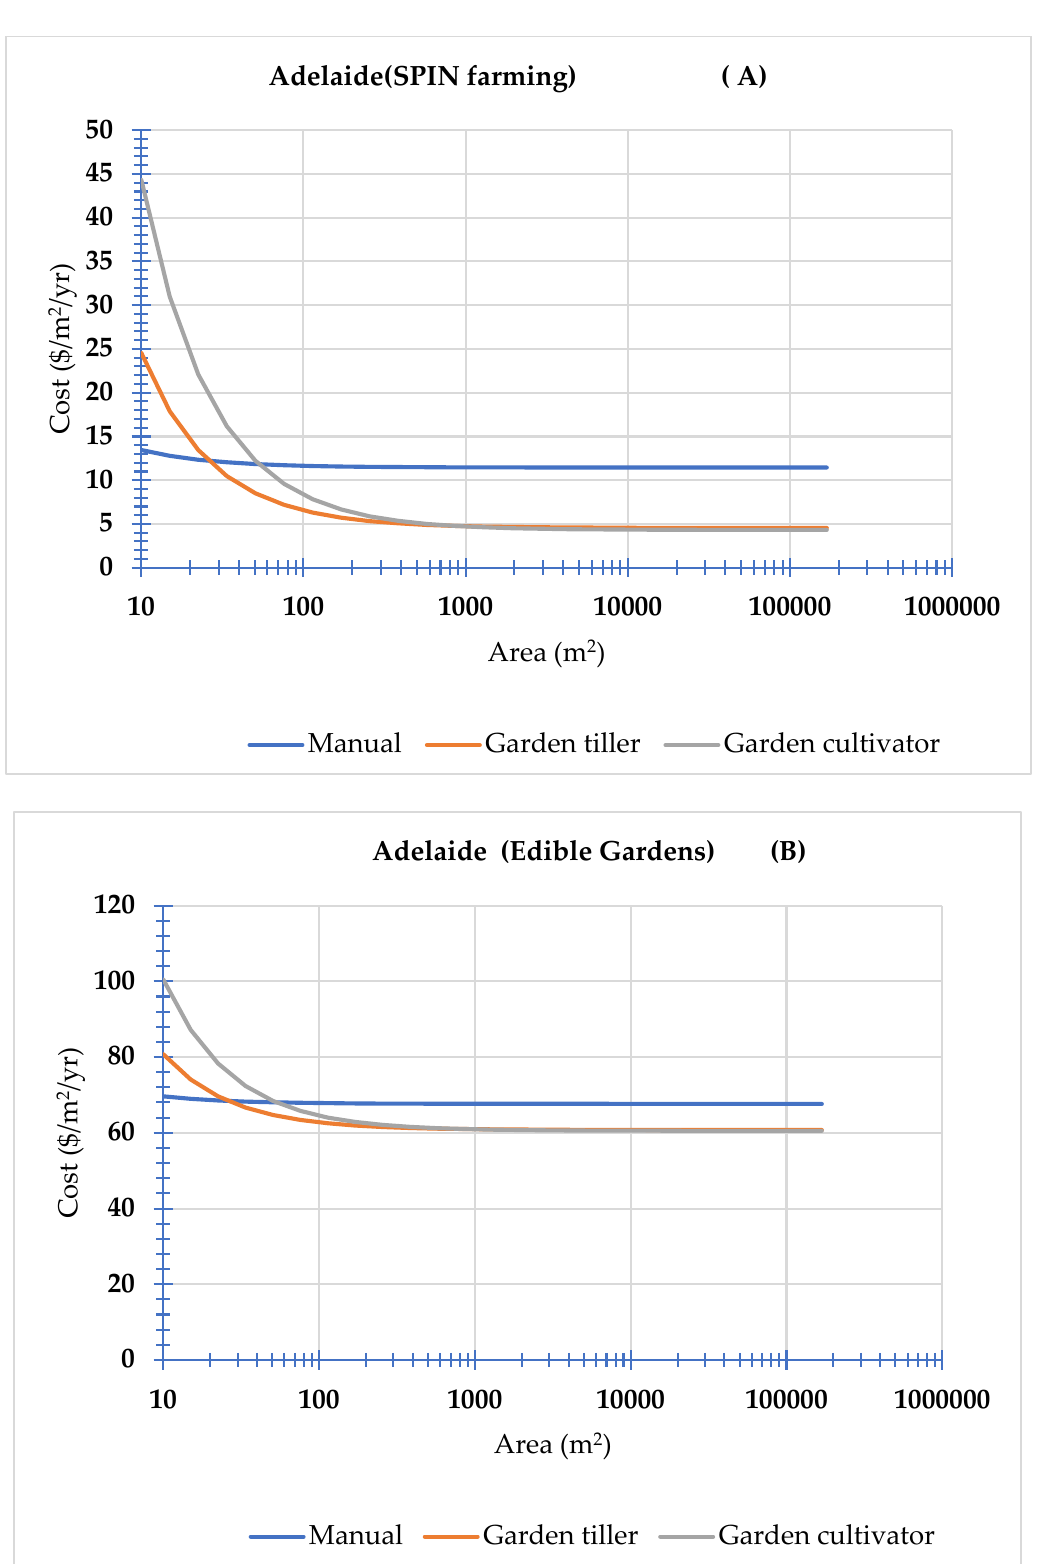
Figure 6. ( A , B ). The economy of scale calculation in Adelaide.